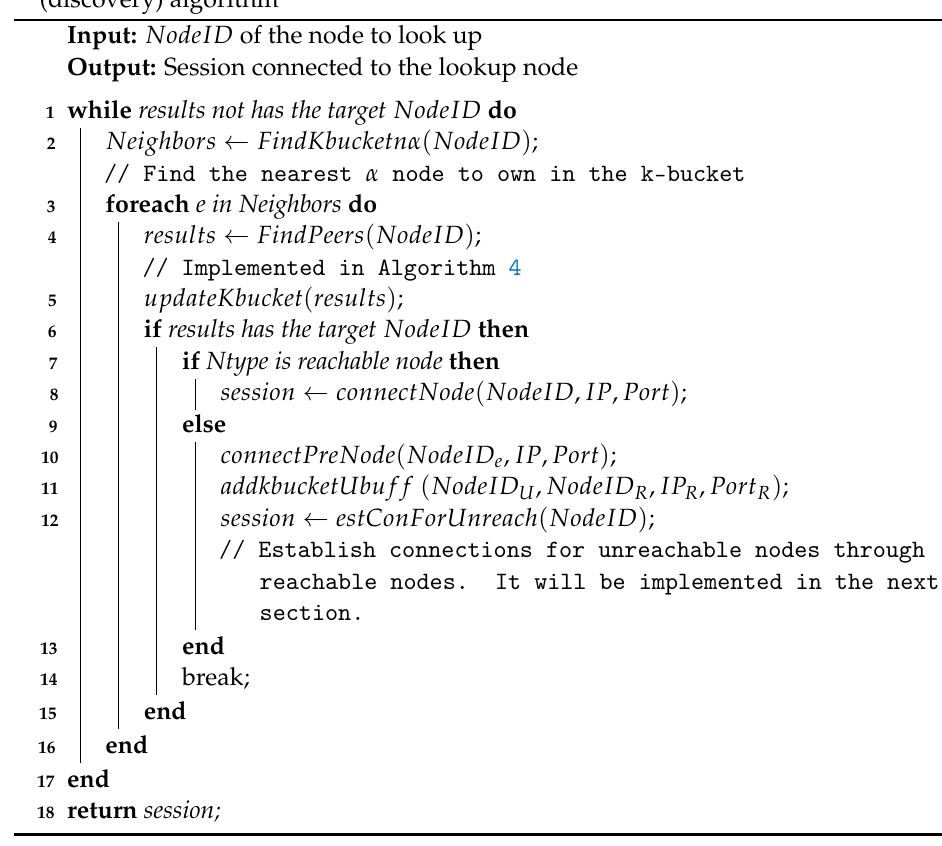
Algorithm 3: Nodes (reachable nodes R , unreachable nodes U ) lookup (discovery) algorithm